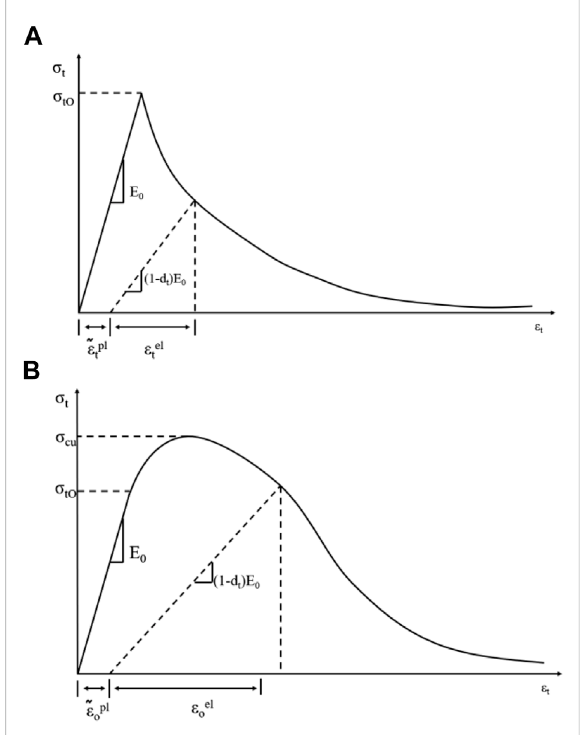
FIGURE 1 Tensionandcompressioncurvesofconcrete. (A) Concretein CDP model tensile cracking strain; (B) Concrete in CDP model compression cracking